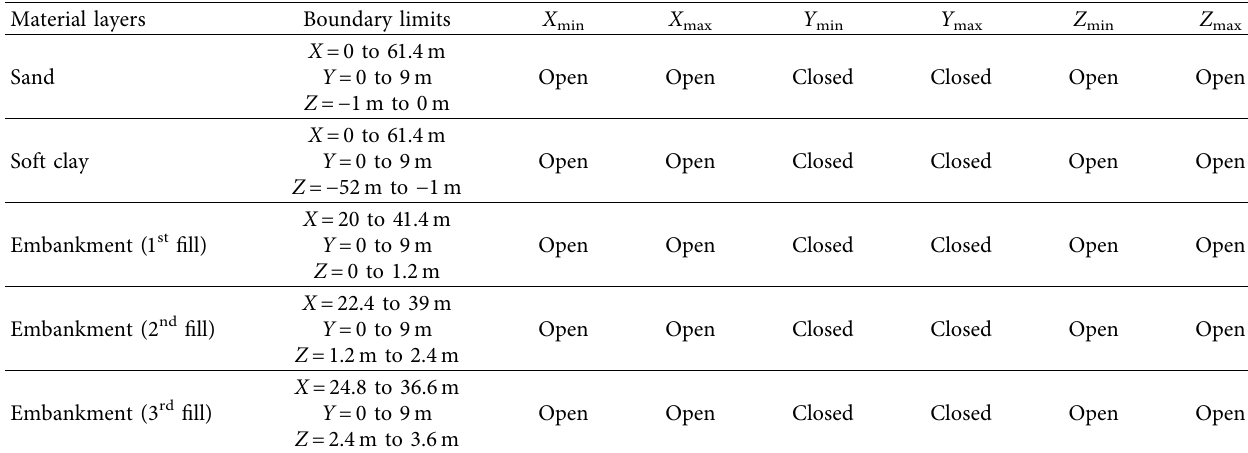
Table 4: Summary of boundary conditions for groundwater fow.